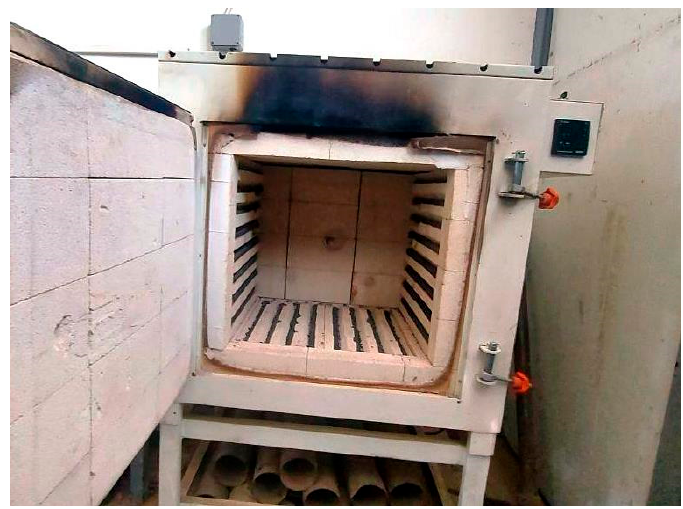
Figure 2. The interiors of the electric furnace.